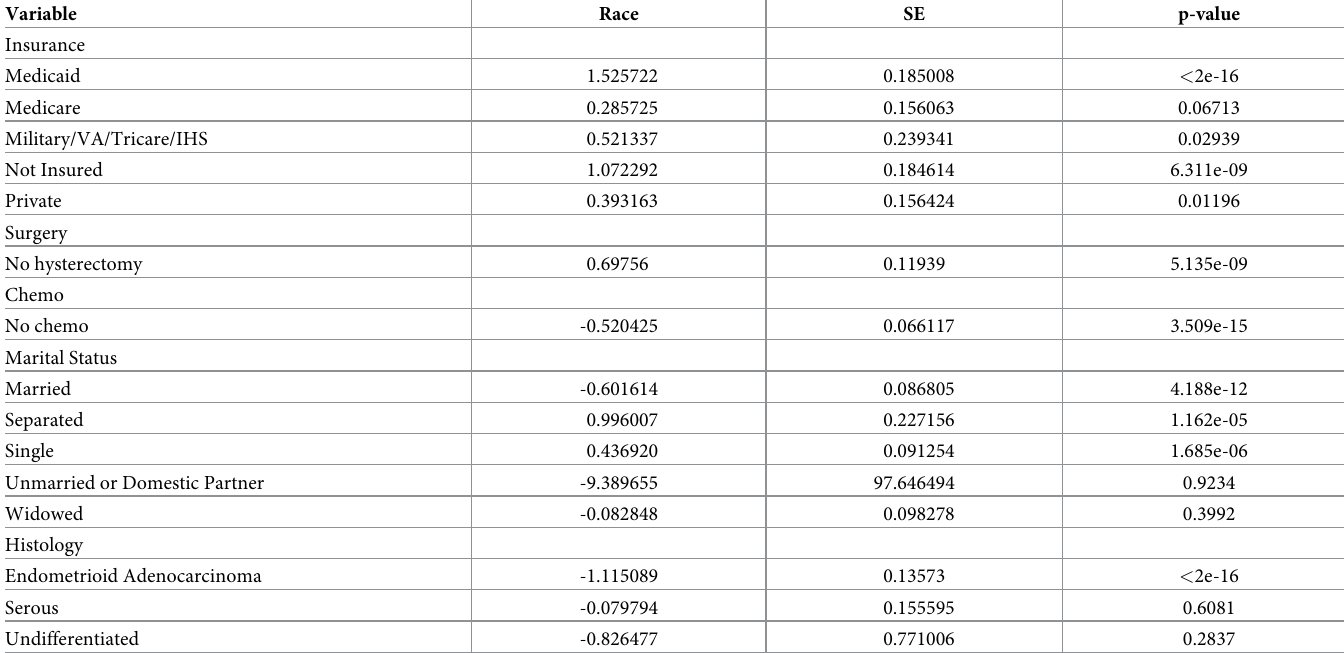
Table 2. Racial differences by variable level.